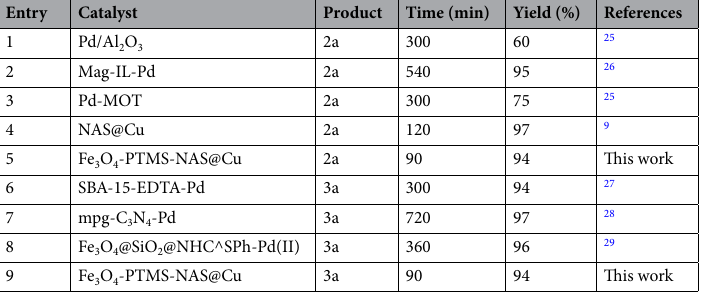
Table 4. Comparison results of Fe 3 O 4 -PTMSNAS@Cu with other catalysts in the synthesis of 2a and 3a